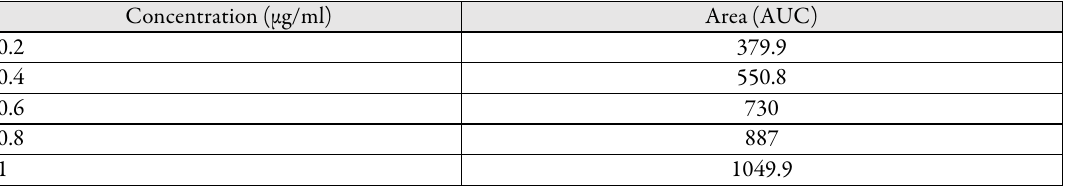
Table 4. Concentration and Area Under Curve (AUC)